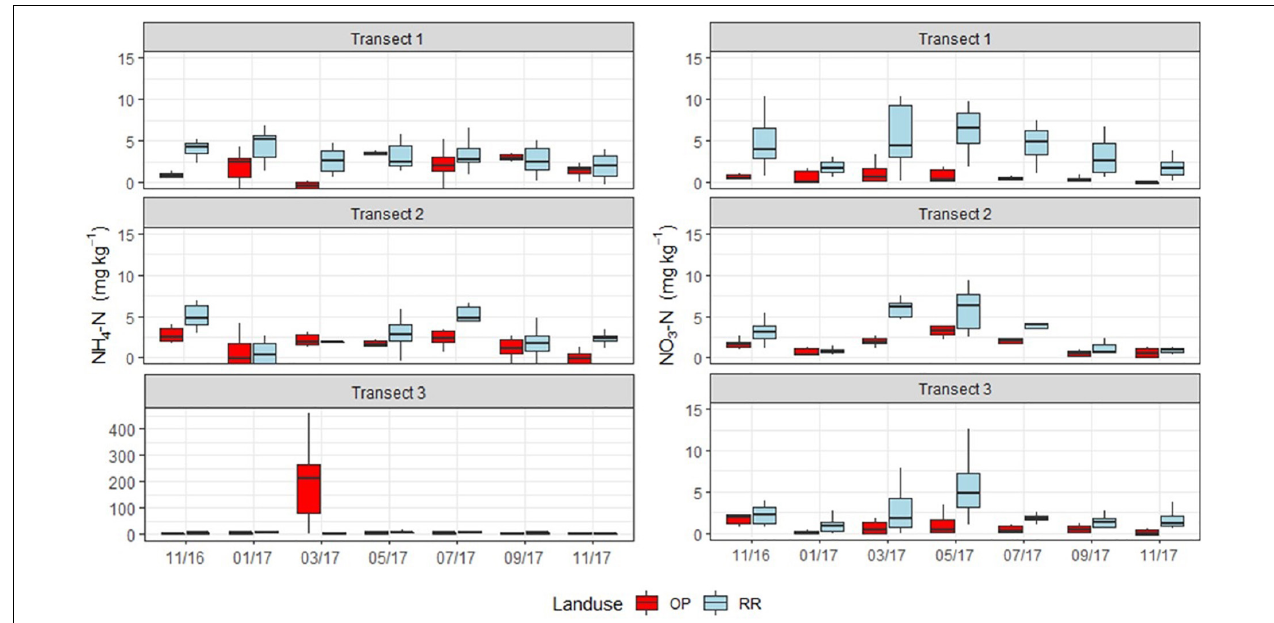
FIGURE 3 | Monthly soil NH 4 -N (left) and NO 3 -N (right) (mg kg − 1 ) concentrations from the three transects (1–3), OP, oil palm (red); RR, riparian forest (blue). The lower and upper hinges correspond to the first and third quartiles (the 25th and 75th percentiles), lower whisker = smallest observation greater than or equal to lower hinge –1.5 × IQR (inter quartile range), upper whisker = largest observation less than or equal to upper hinge +1.5 × IQR. The median is marked by a horizontal line inside the box. Note different y-axis scale for NH 4 -N (left) for the three different